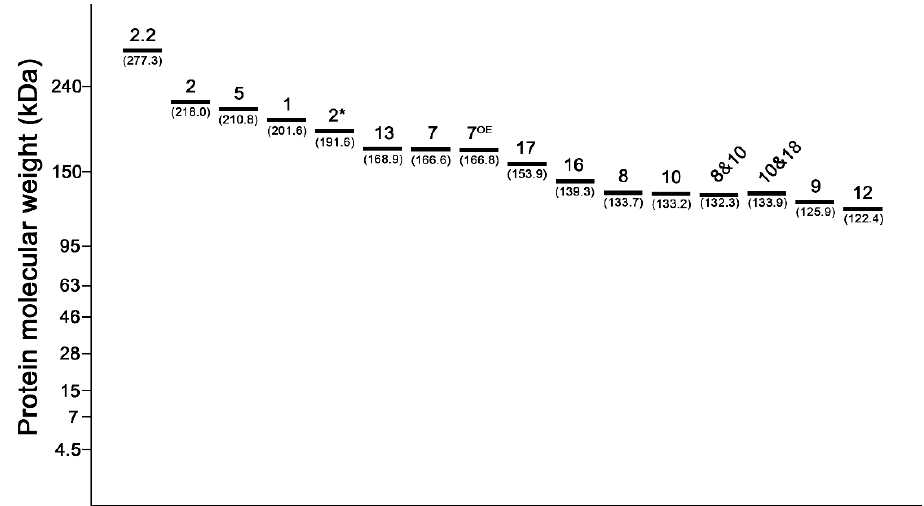
Figure 5. Molecular weights of HMW-GS on Lab-on-a-chip. The mean of each HMW-GS was calculated by analyzing of molecular weight of each HMW-GS from the genetic resources. The small numbers on the image mean each HMW-GS, such as 2 is 1Dx2 and 5 is 1Dx5.